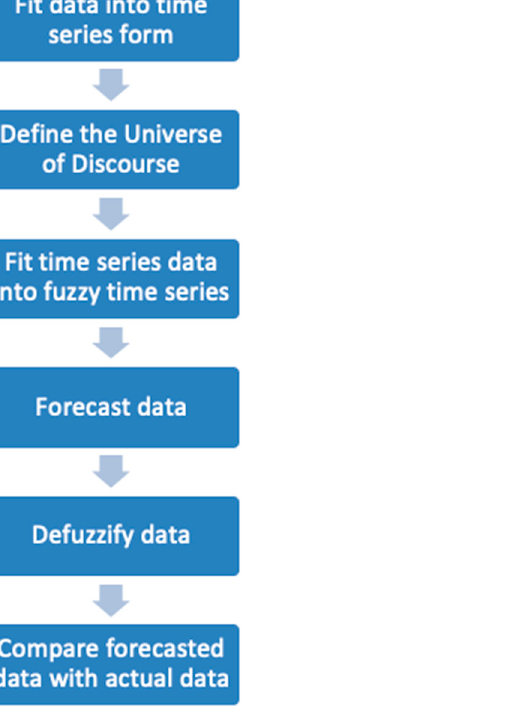
Figure 3. Basic forecasting steps using the fuzzy time series.